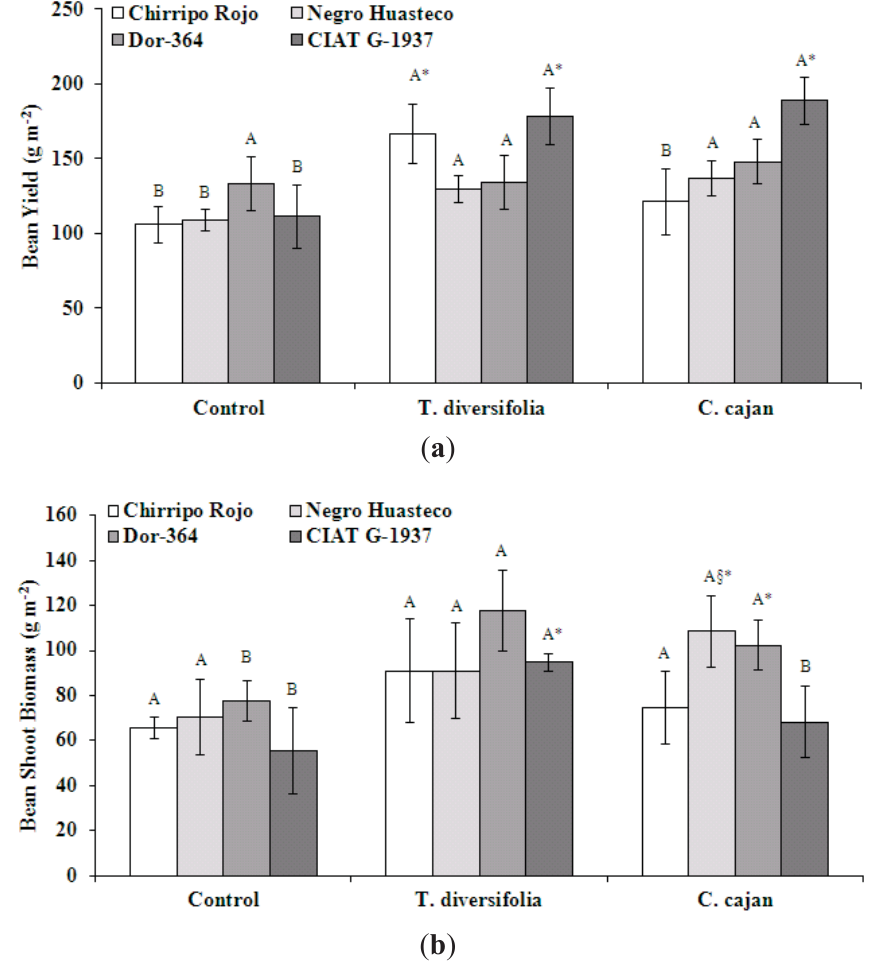
Figure 1. ( a ) Bean yield (g m (cid:237) 2 ) at harvest of four different bean genotypes in treatments with no mulch or mulch from T. diversifolia or C. cajan on a Costa Rican Andosol. Different upper case letters above standard error bars indicate significant differences at p < 0.05 in the comparison of mulch treatments within the same genotype. Values followed by *, comparing differences between bean genotypes and within mulch treatments, are significantly different at p < 0.05; ( b ) Bean shoot biomass (g m (cid:237) 2 ) at the flowering phase of four different genotypes in treatments with no mulch or mulch from T. diversifolia or C. cajan on a Costa Rican Andosol. Different upper case letters above standard error bars indicate significant differences at p < 0.05 in the comparison of mulch treatments within the same genotype ( § C. cajan was significantly different from the control only). Values followed by *, comparing differences between bean genotypes and within mulch treatments, are significantly different at p <